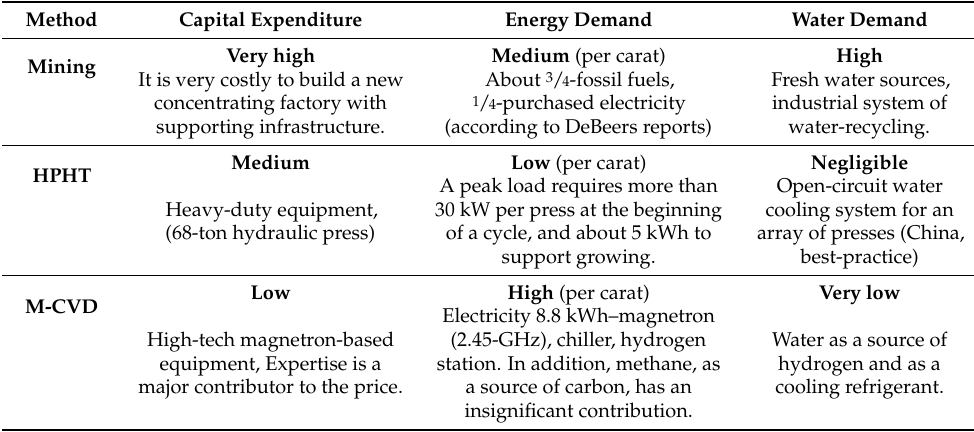
Table 5. Comparison of CAPEX, energy, and water required for different